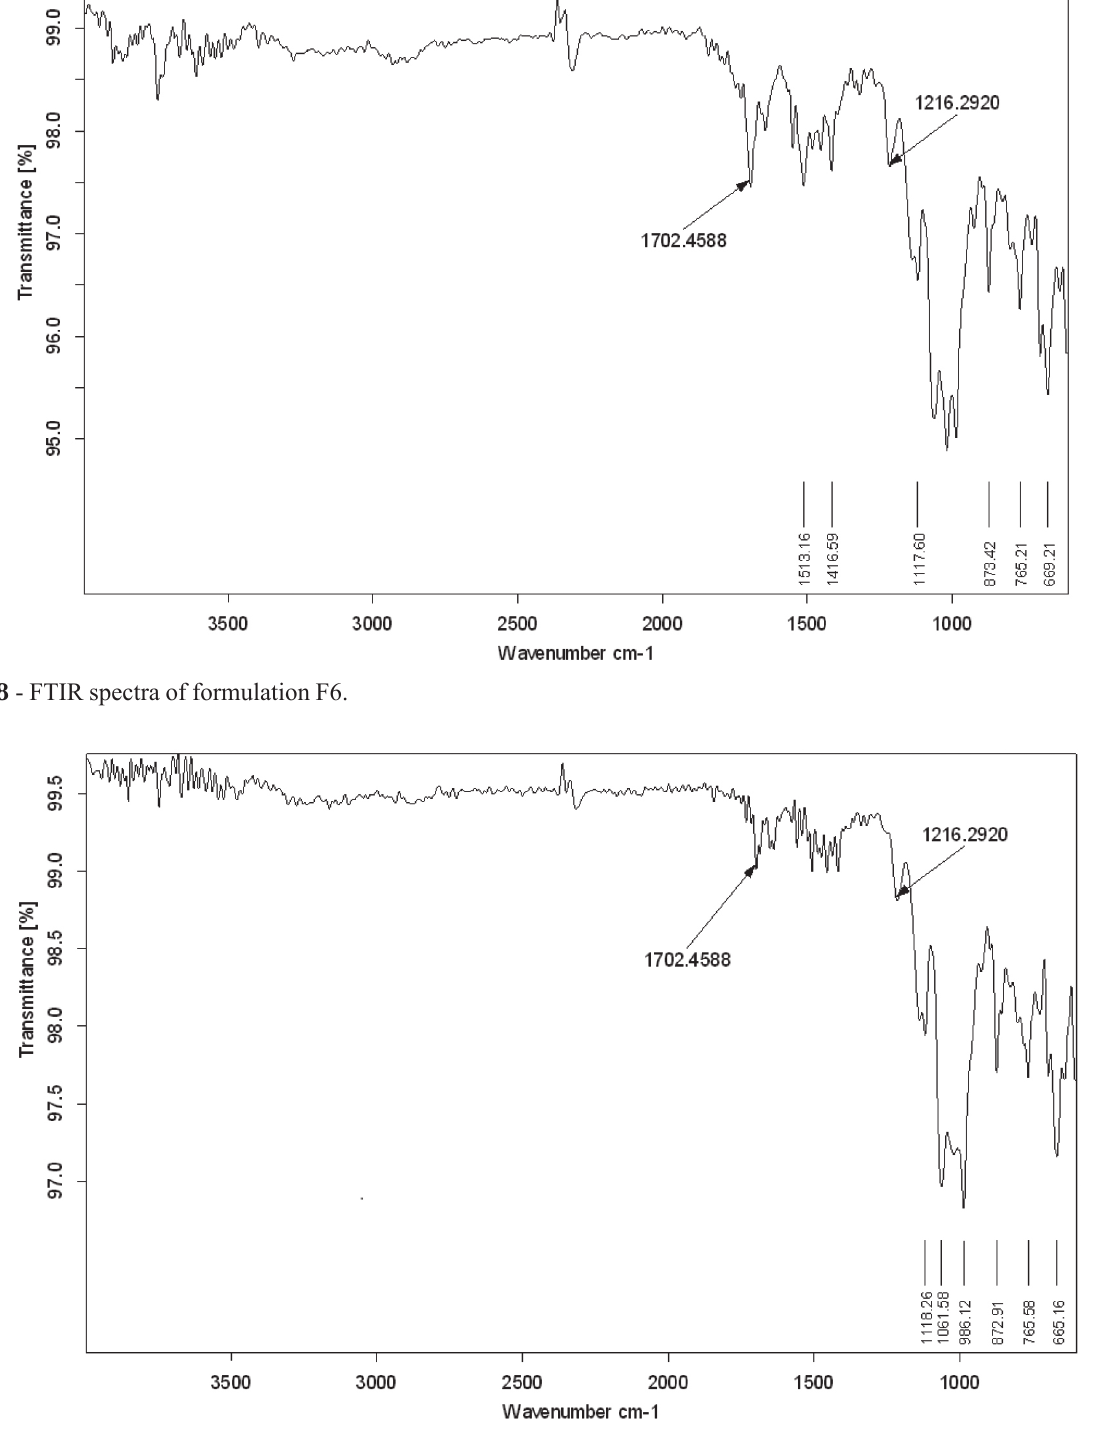
FIGURE 9 - FTIR spectra of formulation